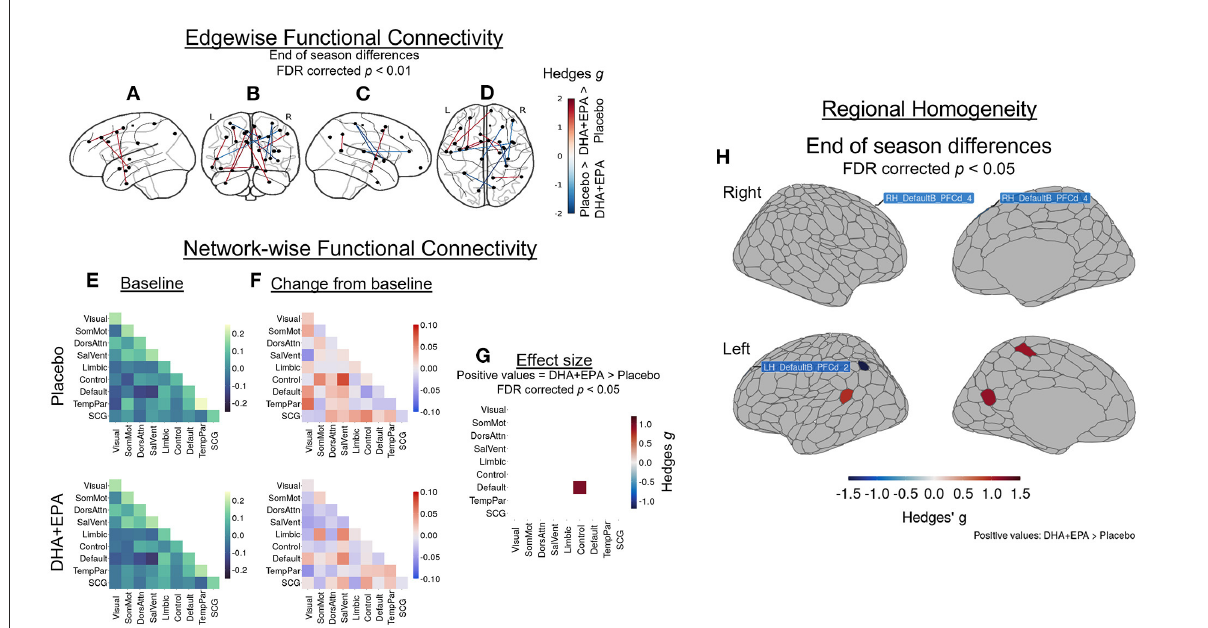
FIGURE5 Group-wise differences in changes in inter- and intra-regional functional connectivity following treatment. Changes in functional connectivity were evaluated using baseline-adjusted ANCOVA models at an inter-regional (“edgewise”) (A–D) , network (E–G) , and local (regional homoegeneity) level. Findings are reported as Hedges g effect sizes. A total of 14 edges exhibited large between-group differences (| g | > 1.48, FDR corrected p < 0.01) and DHA + EPA supplementation was associated with increased connectivity in nine edges, primarily linking salience/ventral attention, limbic, and subcortical regions. These edgewise connections are overlaid on the left hemisphere surface (A) , a coronal view (B) , the right hemisphere surface (C) , and an axial view (D) . Simple differences from baseline (E) to post-treatment in network-wise functional revealed general patterns of increase in the placebo group ( F , top) and decreases in the DHA + EPA group ( F , bottom). Baseline-adjusted network models revealed greater connectivity between the FrontoPartietal Control network and the Default Mode Network in the DHA + EPA group compared to the placebo group ( g = 0.96, p = 0.024) (G) . Additionally, DHA + EPA was associated with greater regional homogeneity ( g > 1.07) in the left somatomotor cortex as well as an area of the left retrospenium while greater regional homogeneity ( g > 0.97) in the placebo group was observed in bilateral areas of the dorsal prefrontal cortex and one area of the left inferior parietal lobule (all FDR corrected p < 0.05) (H) . Specific region names creating the edges in (A–D) are reported in Supplementary Table 3. Specific region names for those identified in (H) are reported in Supplementary Table